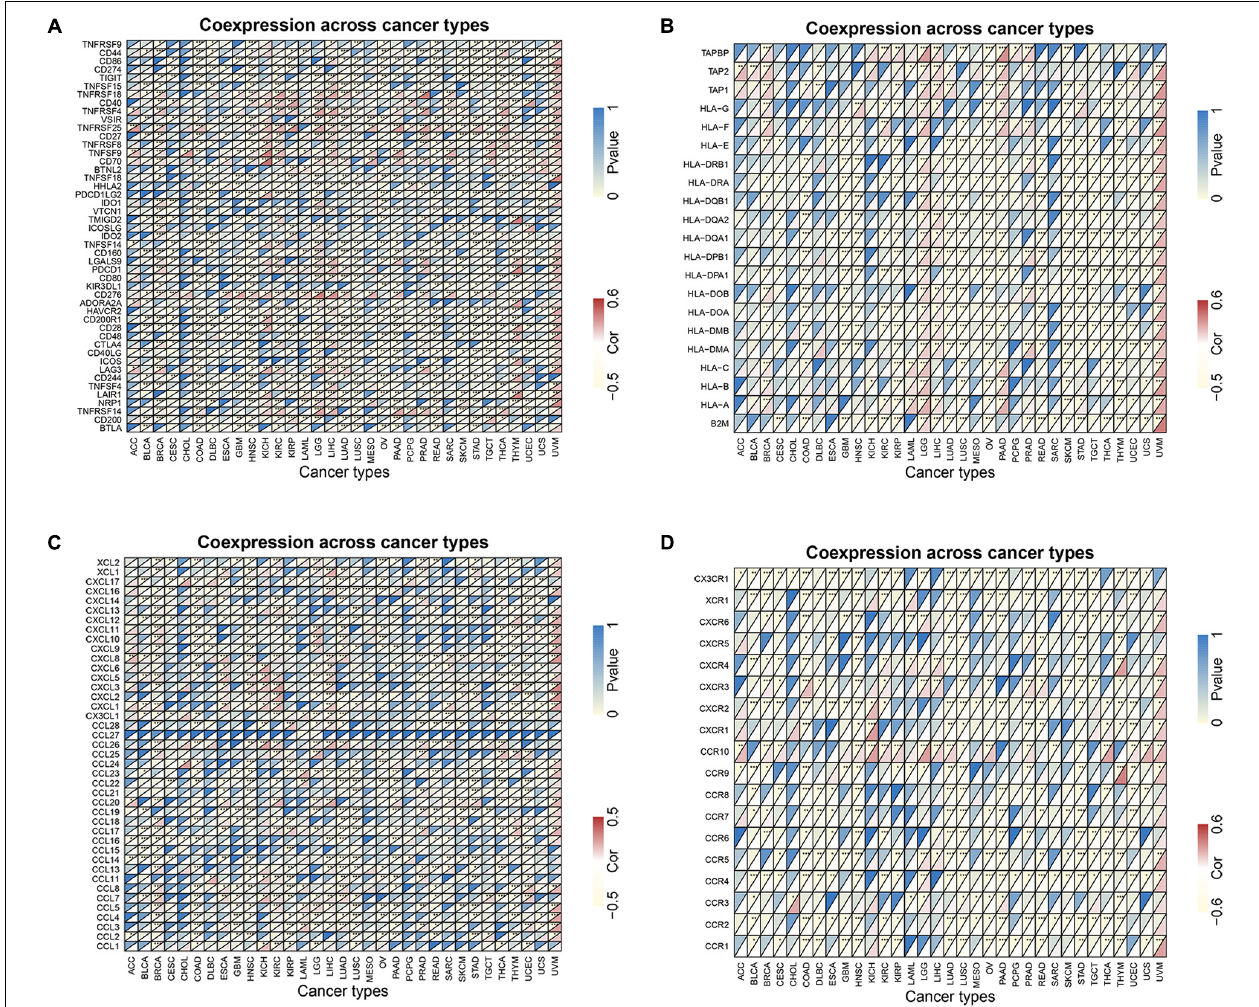
FIGURE 10 | Co-expression of immune-related genes with MRGBP in pan-cancers. (A) Co-expression of immune checkpoint related genes with MRGBP. (B) Co-expression of MHC genes with MRGBP. (C) Co-expression of chemokine genes with MRGBP. (D) Co-expression of chemokine receptor genes with MRGBP.